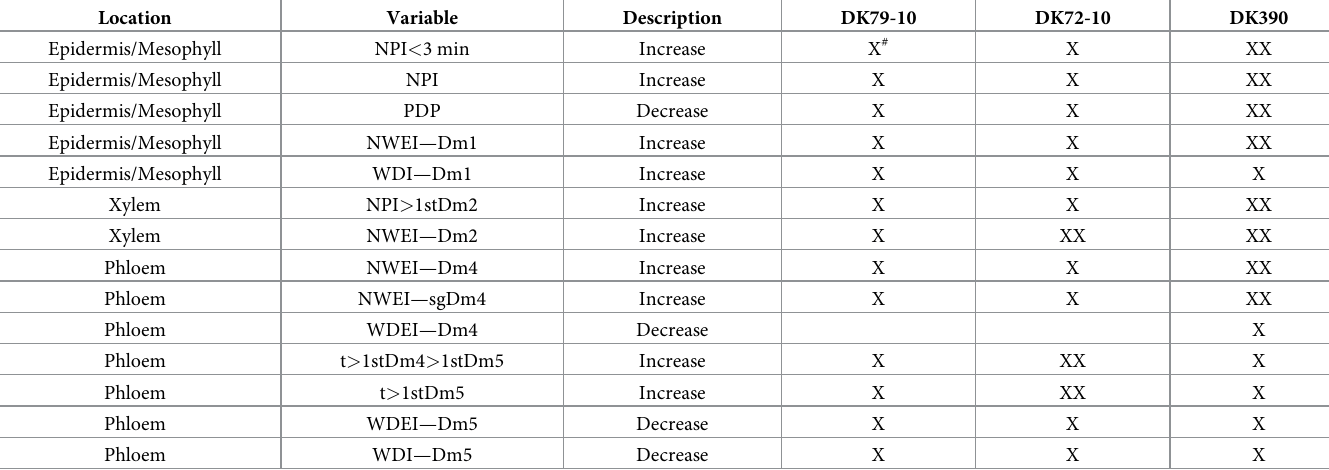
Table 3. Variables of probing behavior of D . maidis insects for hybrids showing significant differences from the susceptible hybrid DK670. Location Variable Description DK79-10 DK72-10